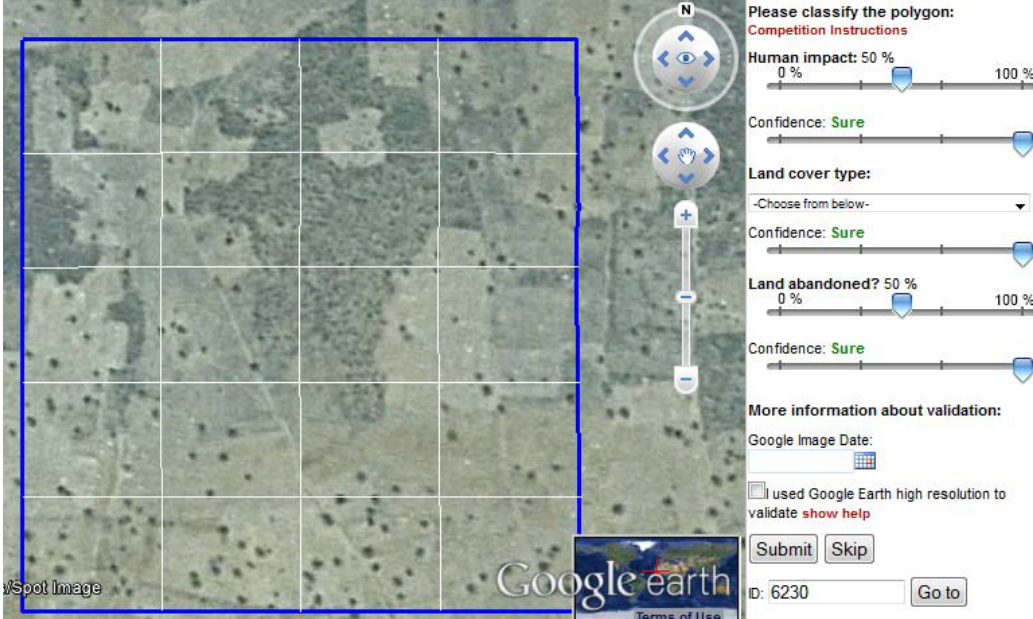
Figure 1. The Geo-Wiki interface used to collect information on land cover type among other features visible from the satellite sensor imagery. visible from the satellite sensor